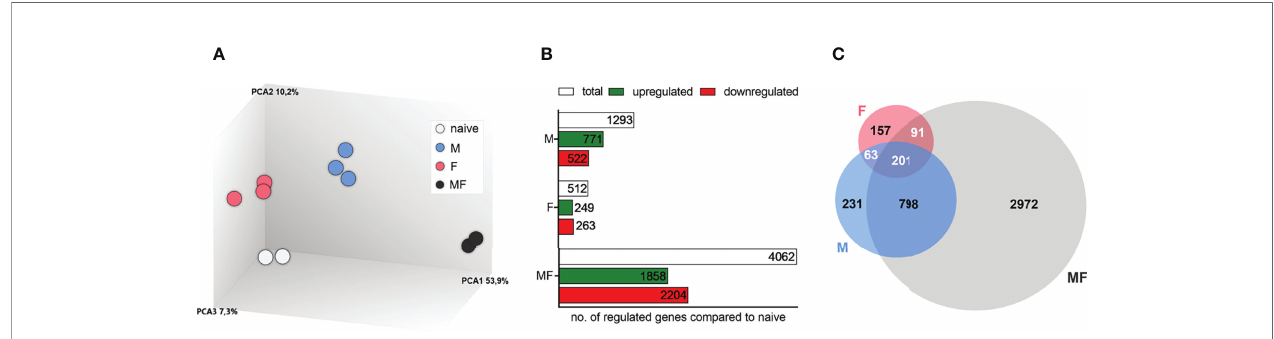
FIGURE 2 | Transcriptomic analysis of spleens of mice uni- and bisexually infected with Schistosoma mansoni . Transcriptomic analysis of spleens reveals different gene expression pro fi les after infection with S. mansoni (8 wk p.i.). (A) Principal component analysis, (B) bar chart, and (C) Venn diagram represent an overview of transcriptomic analysis of spleens ( n = 2 – 3). Inclusion of all genes showing altered gene expression compared to controls (fold change >2 or à2, LIMMA p value < 0.05, and FDR q value < 0.05); M, infected with male cercariae; F, infected with female cercariae; MF, infected with male and